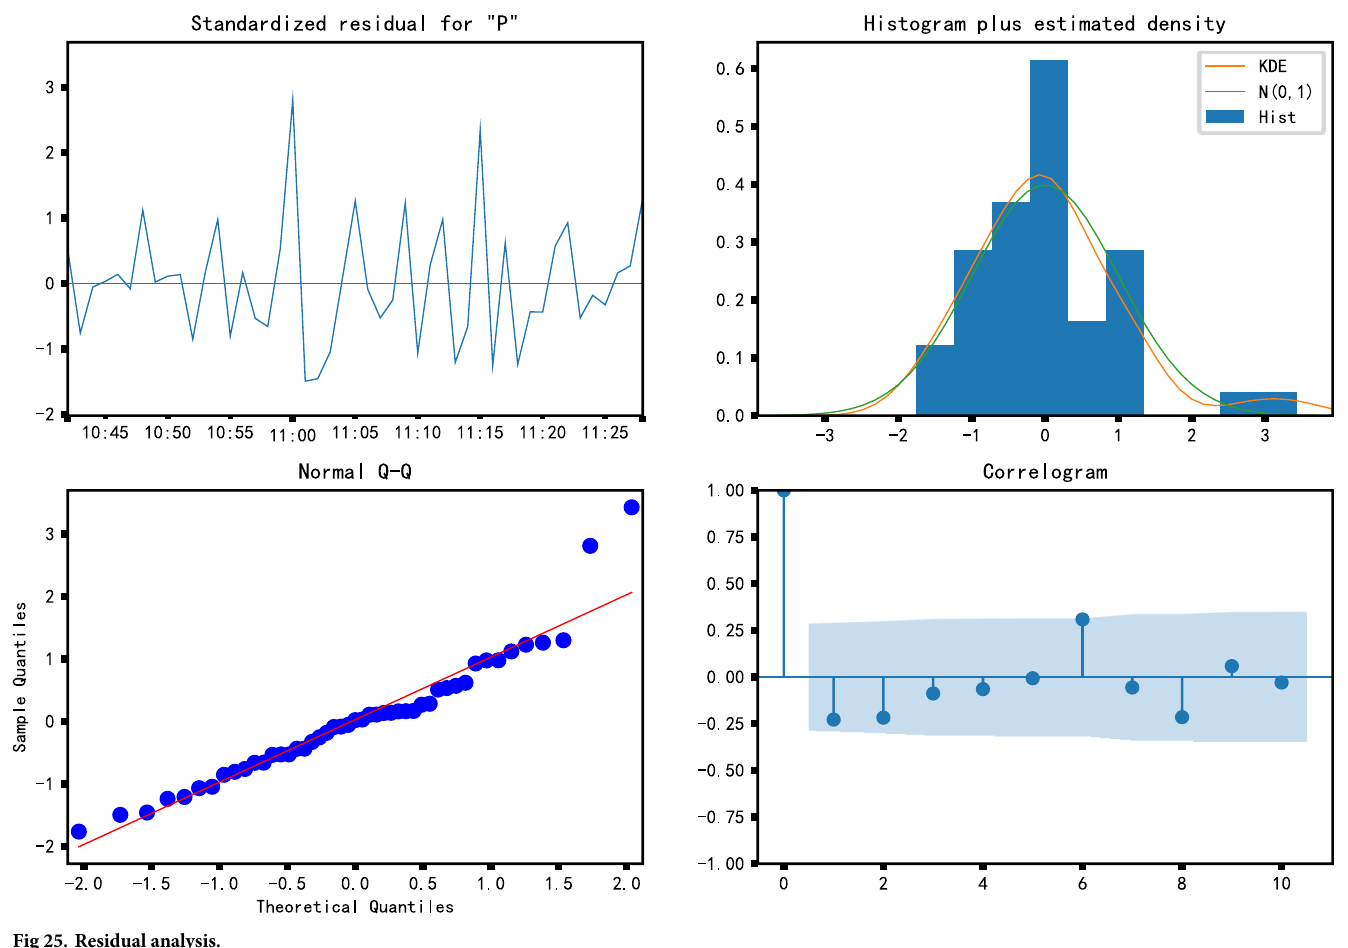
Fig 25. Residual analysis.